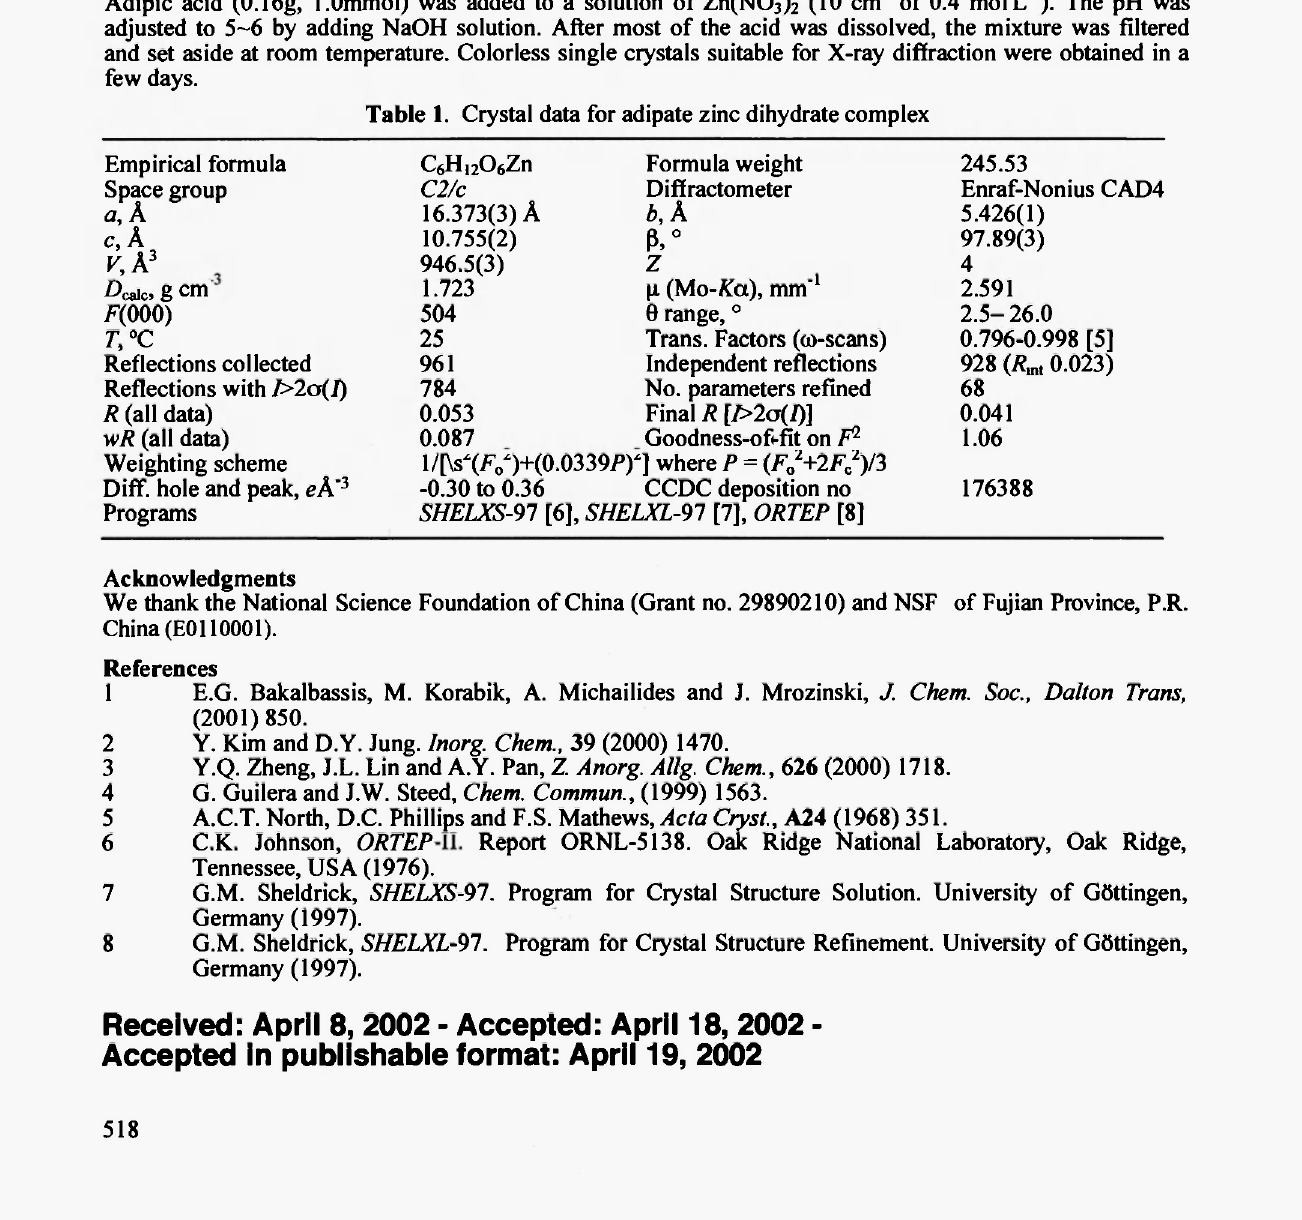
Figure 3. ORTEP plot showing three-dimensional structure of adipate zinc dihydrate connected by H-bonds viewed along the 6-axis.